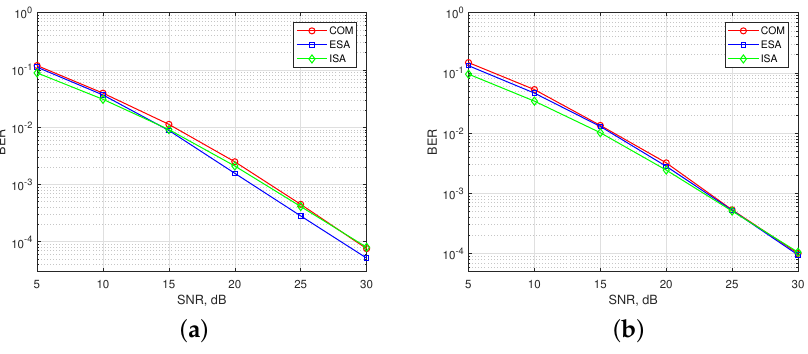
Figure 7. BER performance of synchronous multi-user OFDM-IM regarding to the three SMS-s. ( a ) SMS-s with s = 8 and v = 3. ( b ) SMS-s with s = 8 and v =